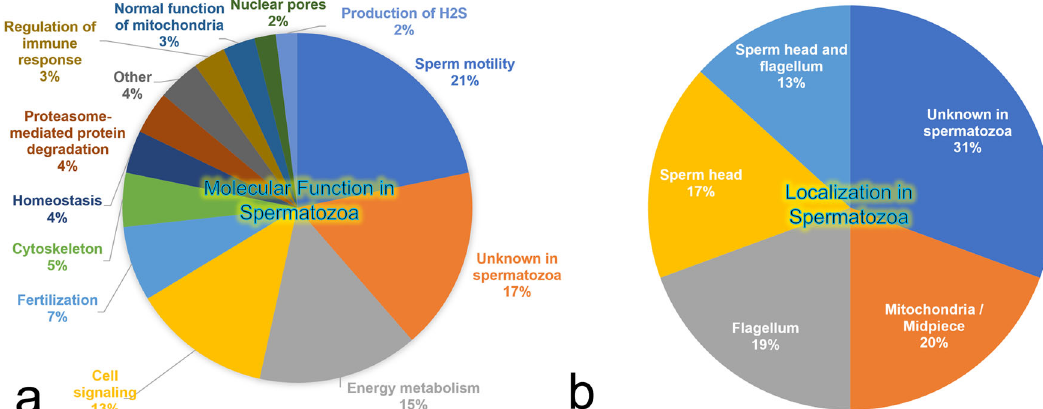
Fig. 5 Molecular function and localization analysis of signi fi cantly different sperm zincoproteins in boar spermatozoa. a Protein function and b cellular